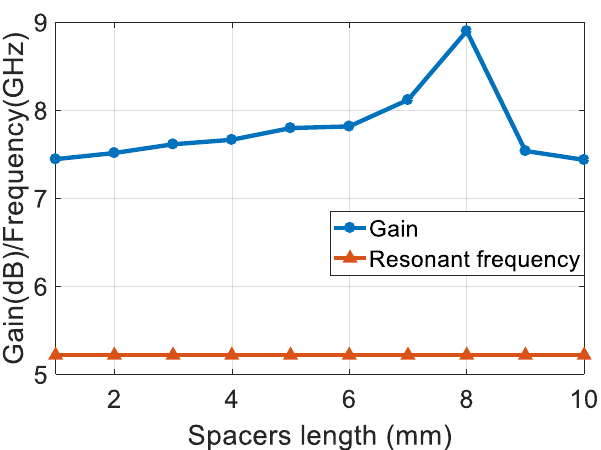
Figure 4: Variation of gain and resonant frequency with spacers length (radius of slot =2 mm)